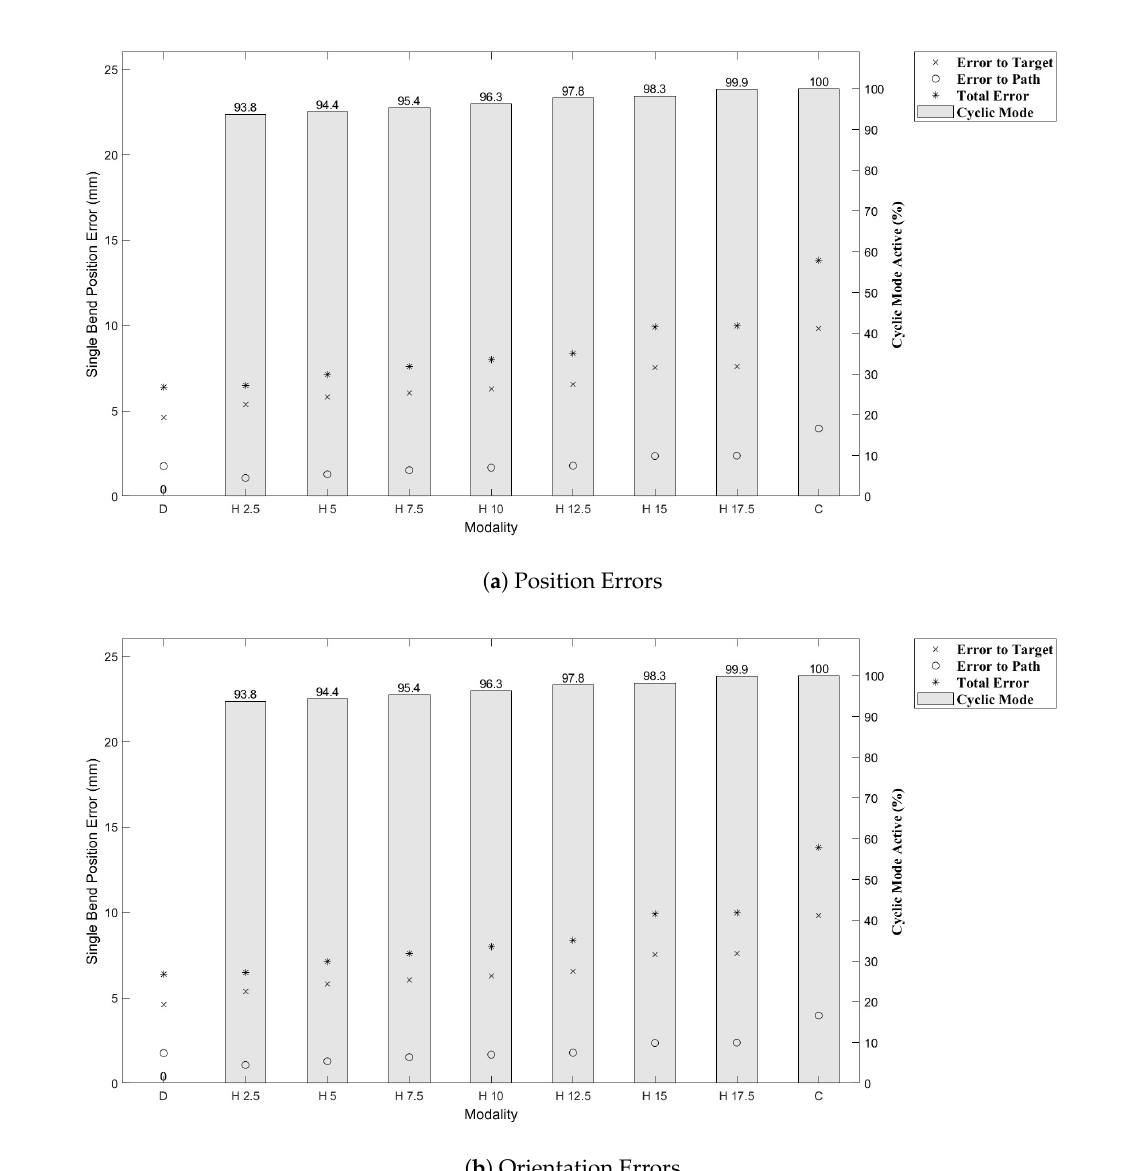
Figure 10. Single bend trajectory errors with per cent CAC active time shown as the bar